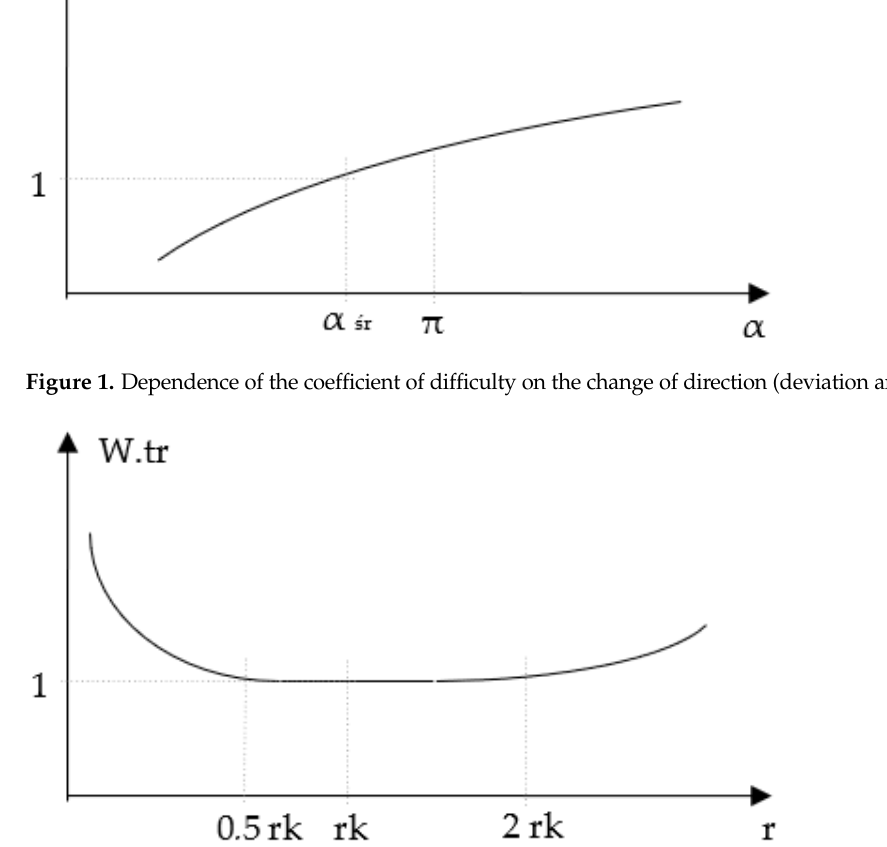
Figure 1. Dependence of the coefficient of difficulty on the change of direction (deviation angle = ½ α ).